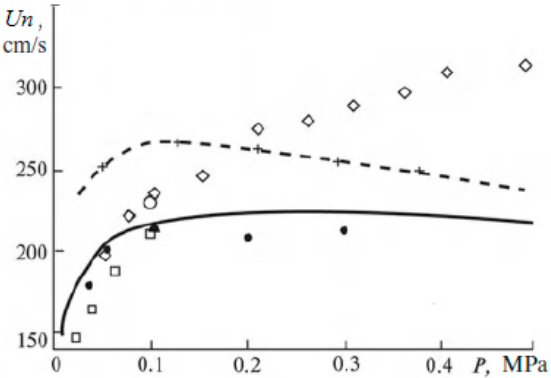
Figure 2. Flame velocity versus pressure in a stoichiometric mixture of hydrogen and air at T 0 = 298 K. Dots are data from various experiments; lines are results of calculations (Adapted with permission from ref. [19]. Copyright 2012, Springer).